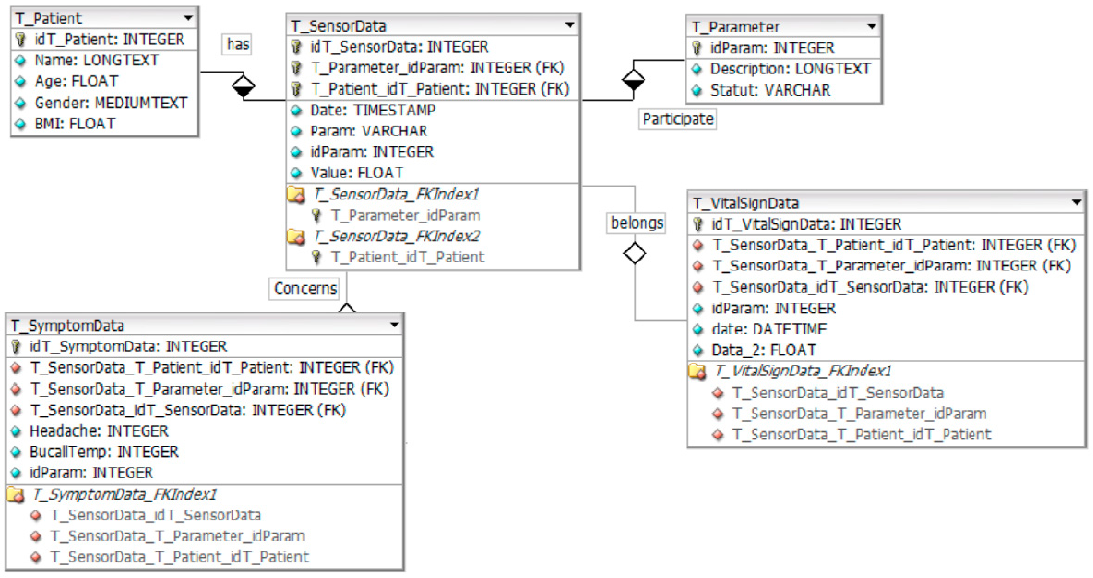
Figure 3. Main components of the data conceptual model.